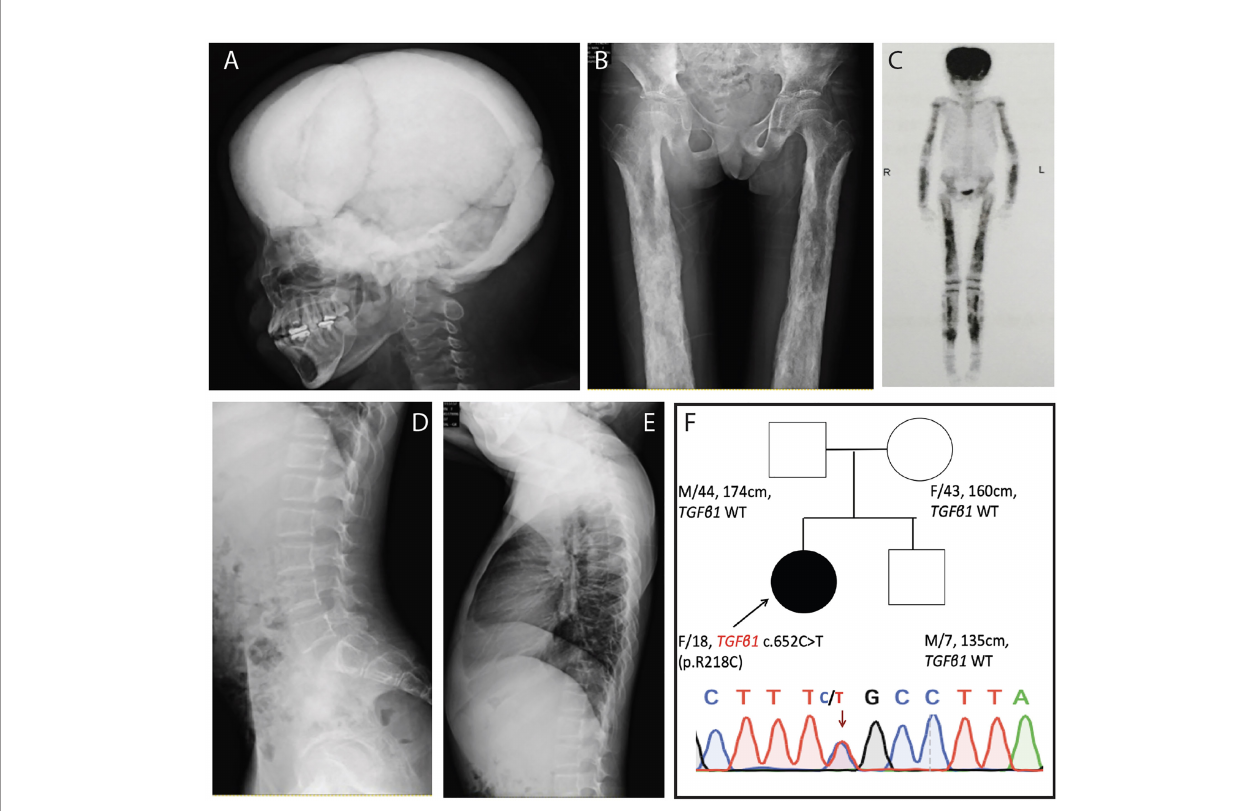
FIGURE 1 | Clinical manifestation of the patient with CED. (A, B) X-ray revealed thickening of skull and thickening of cortices in the diaphysis of both femur. (C) Bone scintigraphy revealed high uptake in skull and the diaphysis of upper and lower limbs. (D, E) X-ray revealed sparse bone trabeculae in thoracic and lumbar spine. (F) Sanger sequencing detected a mutation of c.652C>T (p. R218C) in the gene TGFB1 (NM_000660) in the patient, but neither in her parents nor her brother.